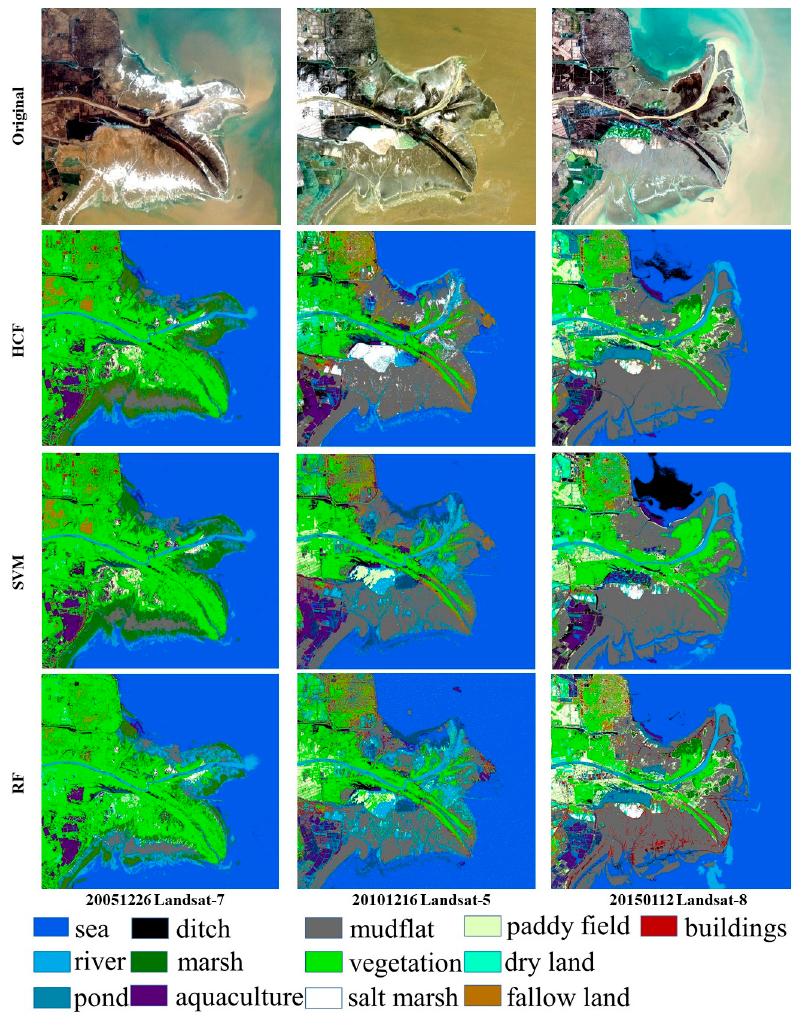
Figure 4. Classification maps of HCF, SVM and RF on the Yellow River Estuary Landsat data.